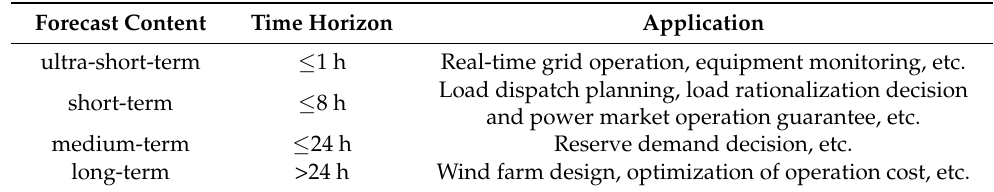
Table 1. Application of different time horizon wind speed forecasting models